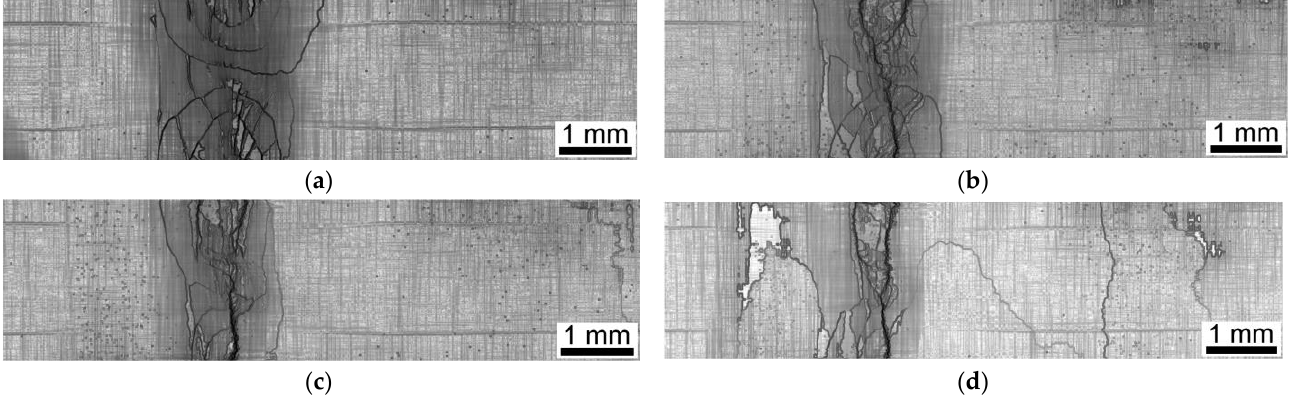
x, y = y / 2,   , it is seen that the longitudinal defor- m mation component varies over a wide range both in the region of localized flow and it is concentrated in copper and steel regions. Negative strain values, as it was mentioned Figure 12. The evolution of deformation structures at the stage of crack propagation (third stage): ( a ) above, are the result of residual compressive stresses, and individual significant strain jumps are due to the layered nature of the original joint. They determine the quality of the “copper - steel” join and are associated with the technological regime of the additive tech- nique. However, in this case, when studying the deformation process, negative values of longitudinal deformation, in essence, is a source of systematic error. Therefore, in order to obtain average strain characteristics at different times, we will take into account only